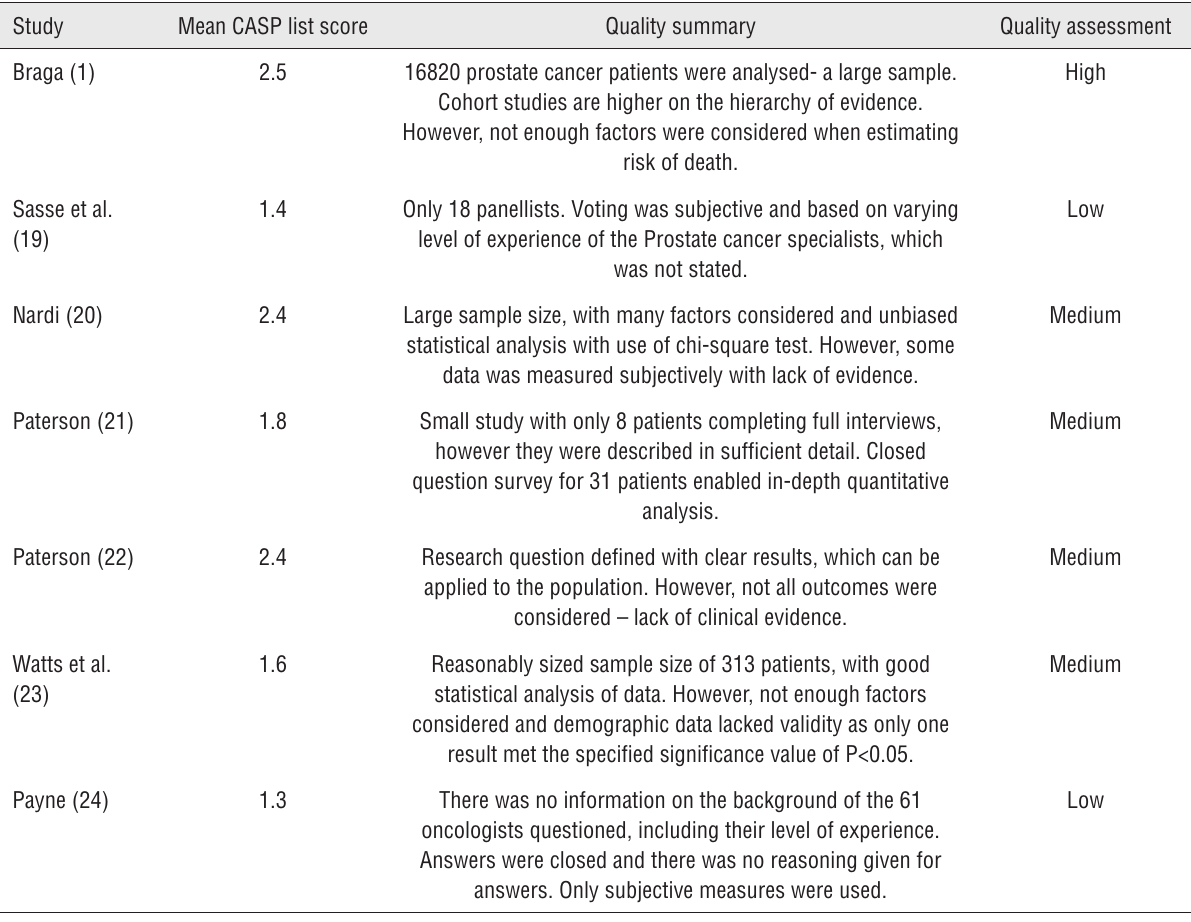
Table 7 – Quality assessment of selected prostate cancer studies using CASP tools. Study Mean CASP list score Quality summary Quality